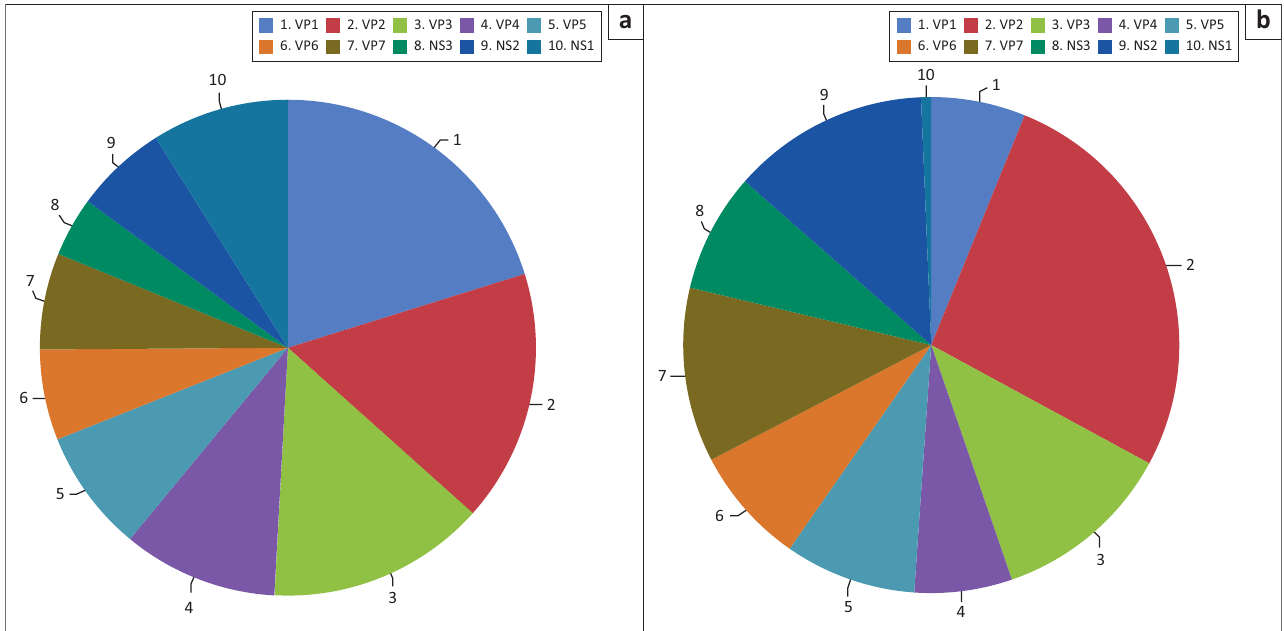
FIGURE 2: Proportional representation of the African horse sickness virus-4 genome segments according to (a) size and (b) actual number of clones in the primary unpanned fragmented-genome phage display library. Segments are colour coded and named according to their encoded protein.